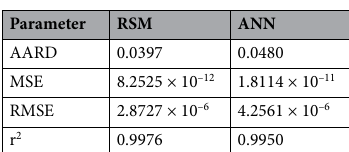
Table 8. Comparison between RSM and